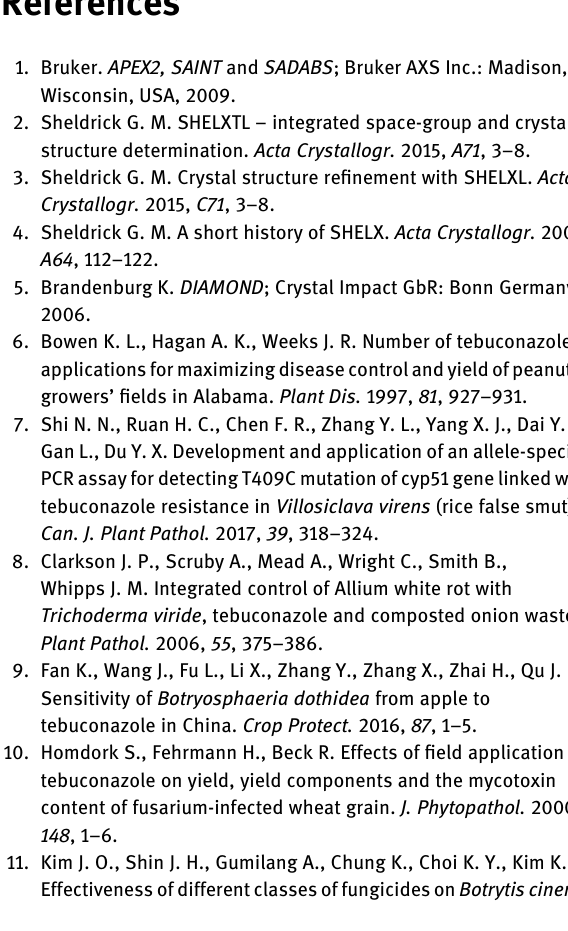
Four neighbouring ions are linked by electrostatic attractions